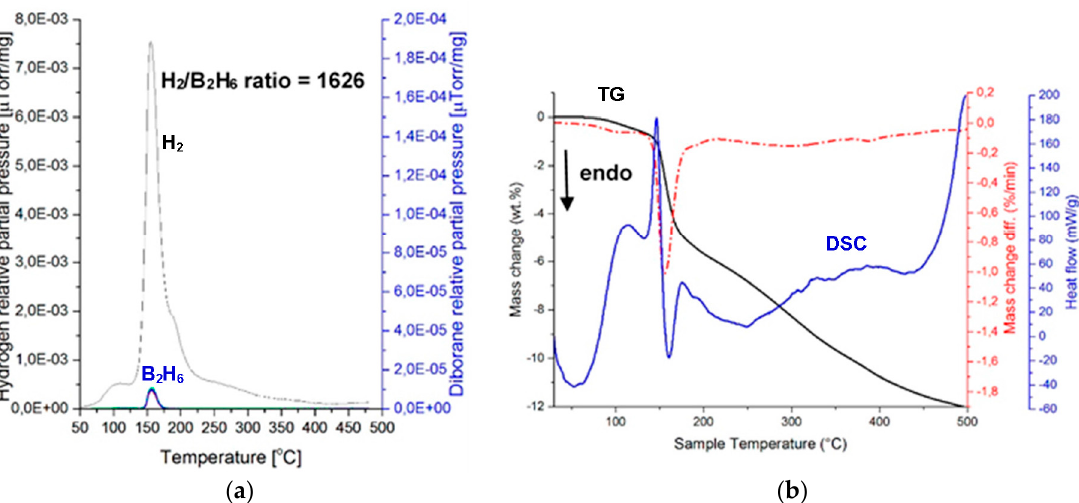
Figure 9. ( a ) Mass spectrometry (MS) (gas desorption spectra) of a (H 2 + B 2 H 6 ) mixture for a (2NaBH 4 + MnCl 2 ) sample, ball milled (BM) for 1 h (Q TR = 72.8 kJ/g) and subsequently extracted at 42 °C/25 min